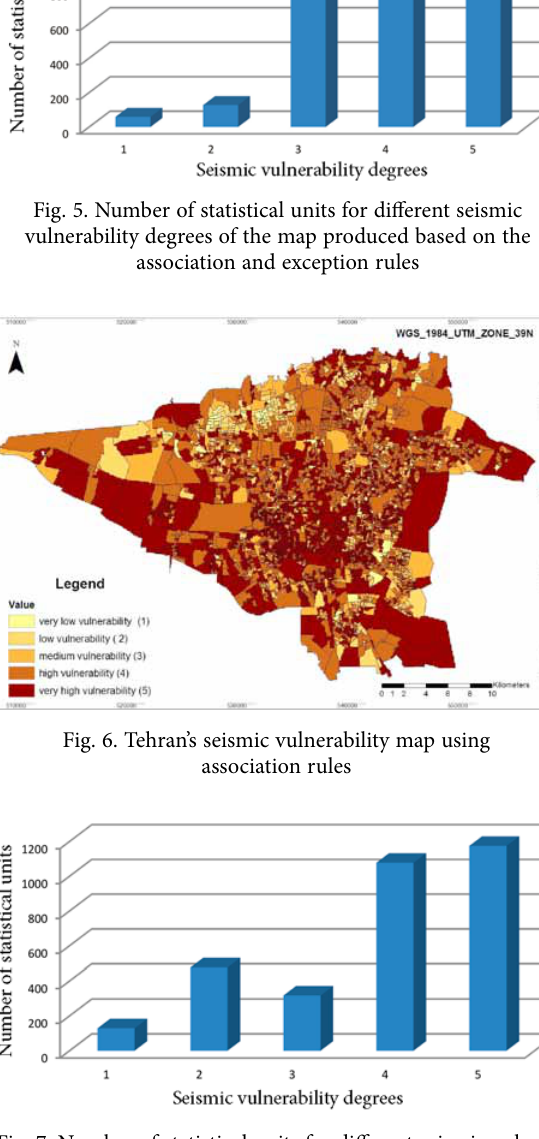
Fig. 7. Number of statistical units for different seismic vulne- rability degrees for map produced based on association